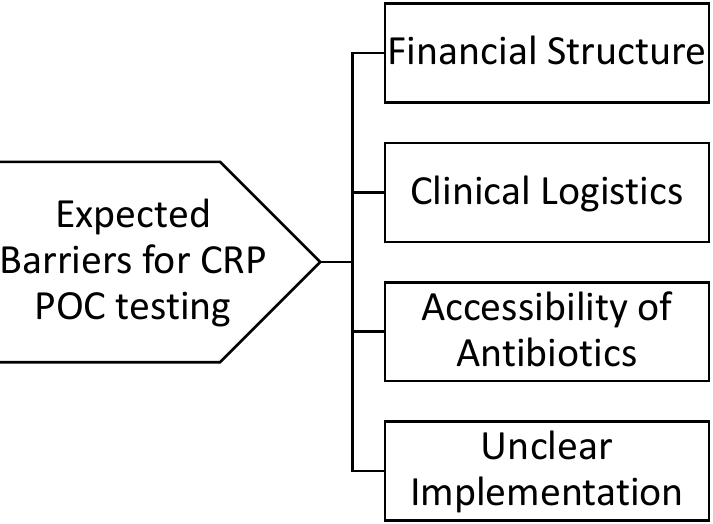
Figure 4. Expected barriers for CRP POC testing.